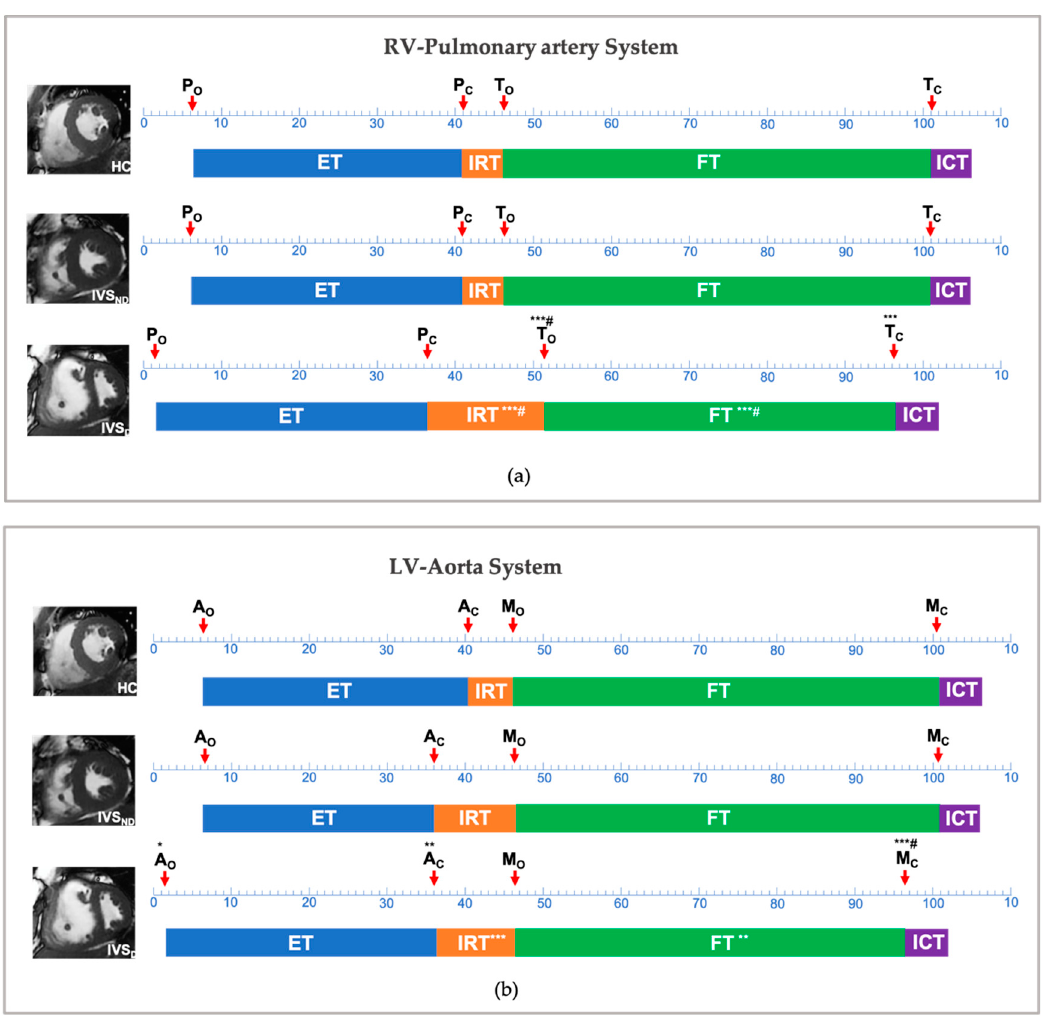
Figure 3. Temporal changes between the HC, IVS ND and IVS D in the right ventricle-pulmonary artery system ( a ) and left ventricle-aorta system ( b ). * p < 0.05, ** p < 0.01, *** p < 0.001: versus HC; # p < 0.05: versus IVS ND ; P, pulmonary artery valve; A, aortic valve; M, mitral valve; T, tricuspid valve; ICT, isovolumetric contraction time; IRT, isovolumetric relaxation time; ET, ejection time; FT, filling time; HC, health control; IVS ND , pulmonary hypertension patients without interventricular septum displacement; IVS D , pulmonary hypertension patients with interventricular septum displacement.